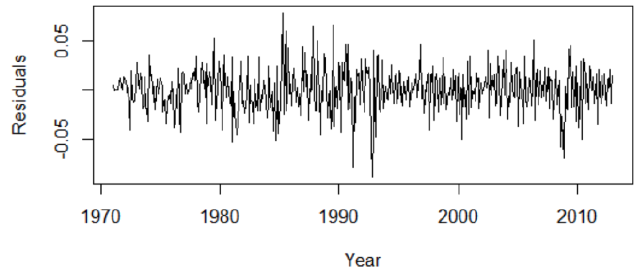
Figure 7: Time series plot of the residuals of the model selected by